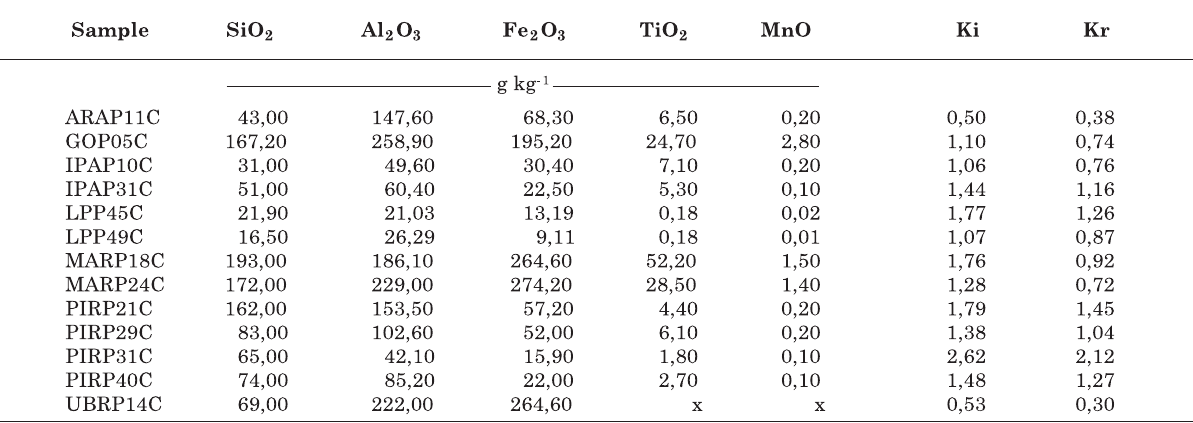
the Soil Spectral